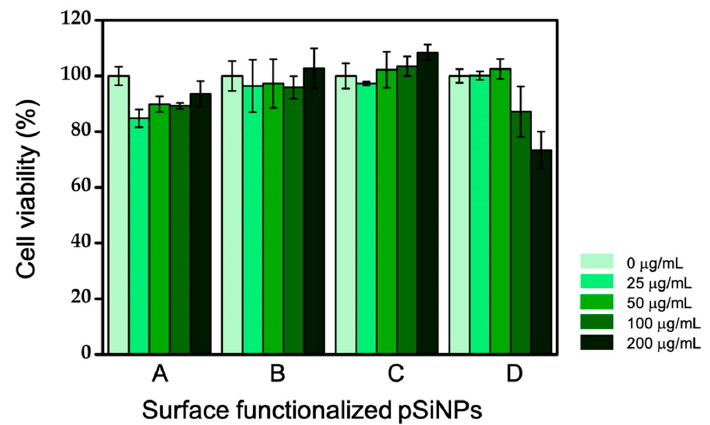
Figure 7. Effect of surface-functionalized pSiNPs samples on the cytotoxicity of HeLa cells. A: pSiNPs-F , B: pSiNPs-F-mPEG , C: pSiNPs-F-NHS , D: pSiNPs-F-MAL . HeLa cells were incubated with